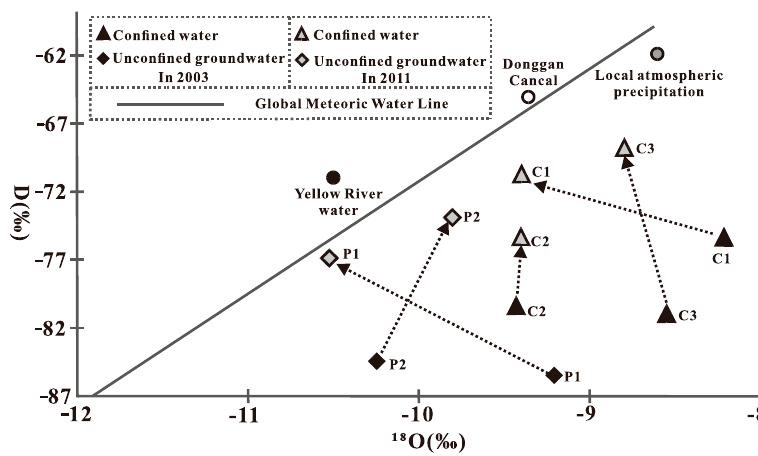
Figure 8. Changes in the values of δ D and δ 18 O (‰).